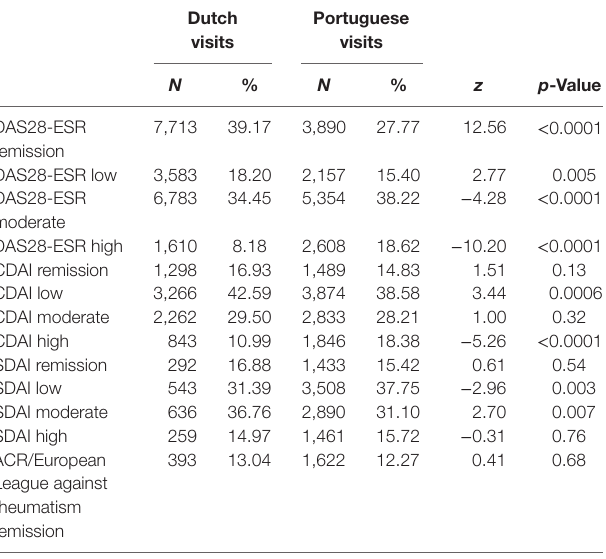
TaBle 3 | The number and percentage of visits in each population according to disease activity state and corresponding z -tests for equality of two independent proportions. Dutch Portuguese visits visits N % N %